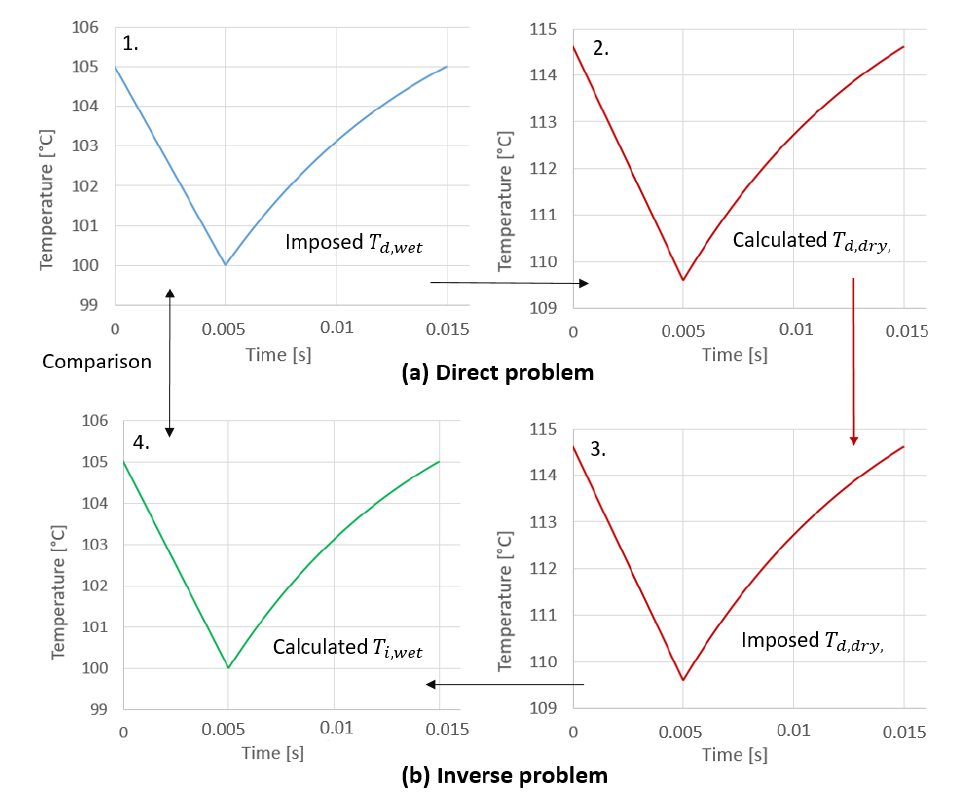
Figure 14. Steps to solve the inverse problem, ( a ) solving the direct problem by imposing the wet temperature (blue curve, 1) to get the dry temperature (2), ( b ) solving the inverse problem by imposing the dry temperature (red curve, 3), calculated before (2) to get the wet temperature (4). As with all inverse problems, it is sensitive to boundary condition uncertainties.